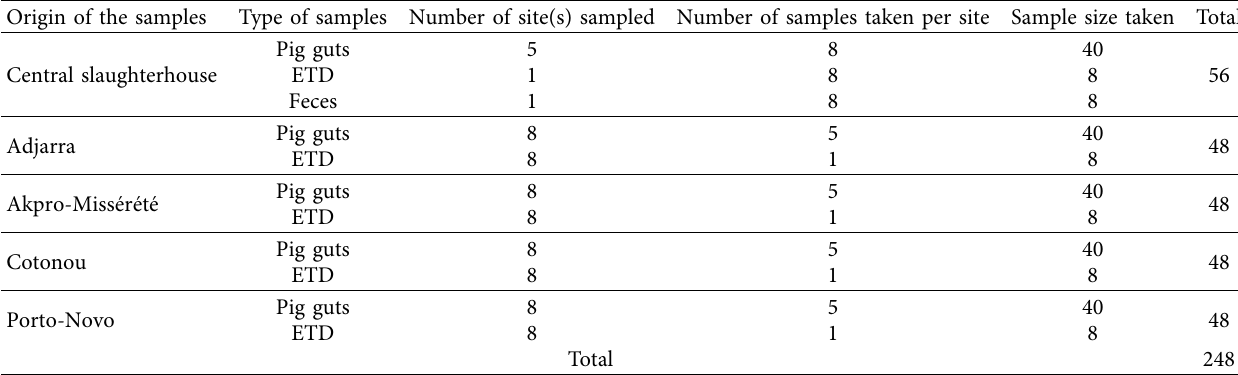
Table 1: Distribution of samples according to their nature and origin. Origin of the